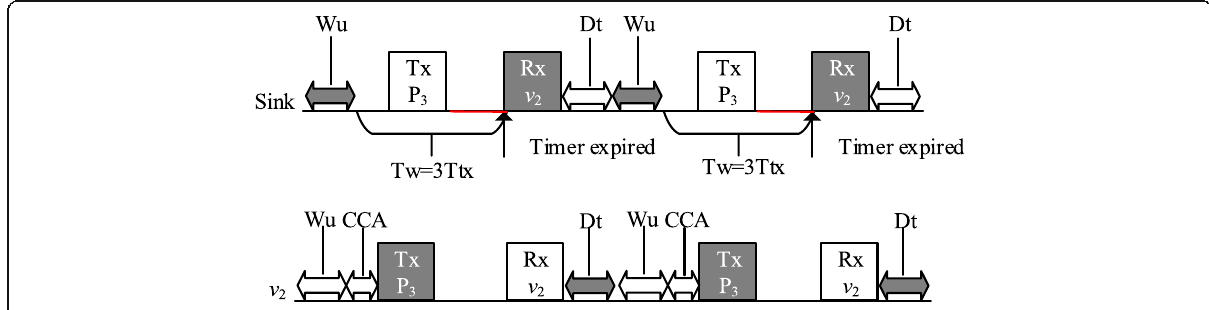
Fig. 6 The transmission process when T w = 3 T tx in network 1